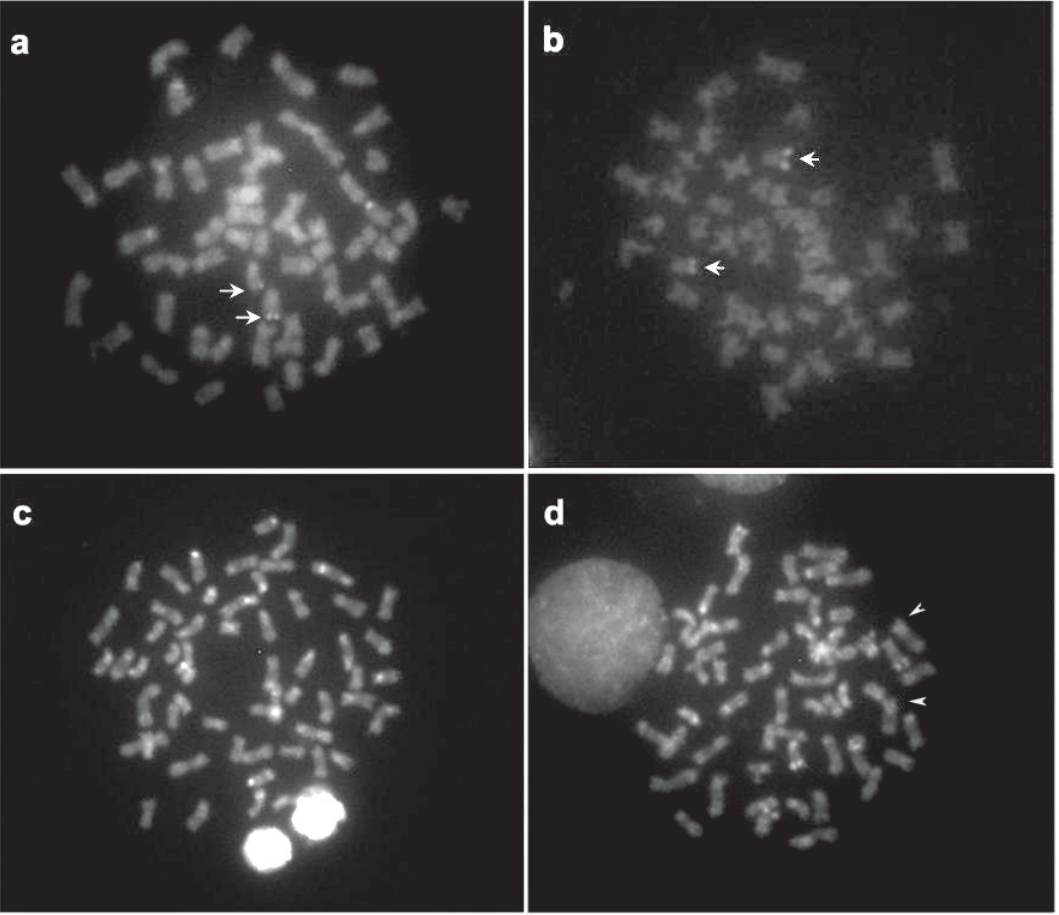
Fig. 3. Somatic metaphases of Parapimelodus nigribarbis : a) CB+CMA and d) CB+DAPI. The arrows indicate the NOR-bearing pair of chromosomes. The arrowheads in (d) indicate the chromosome pair